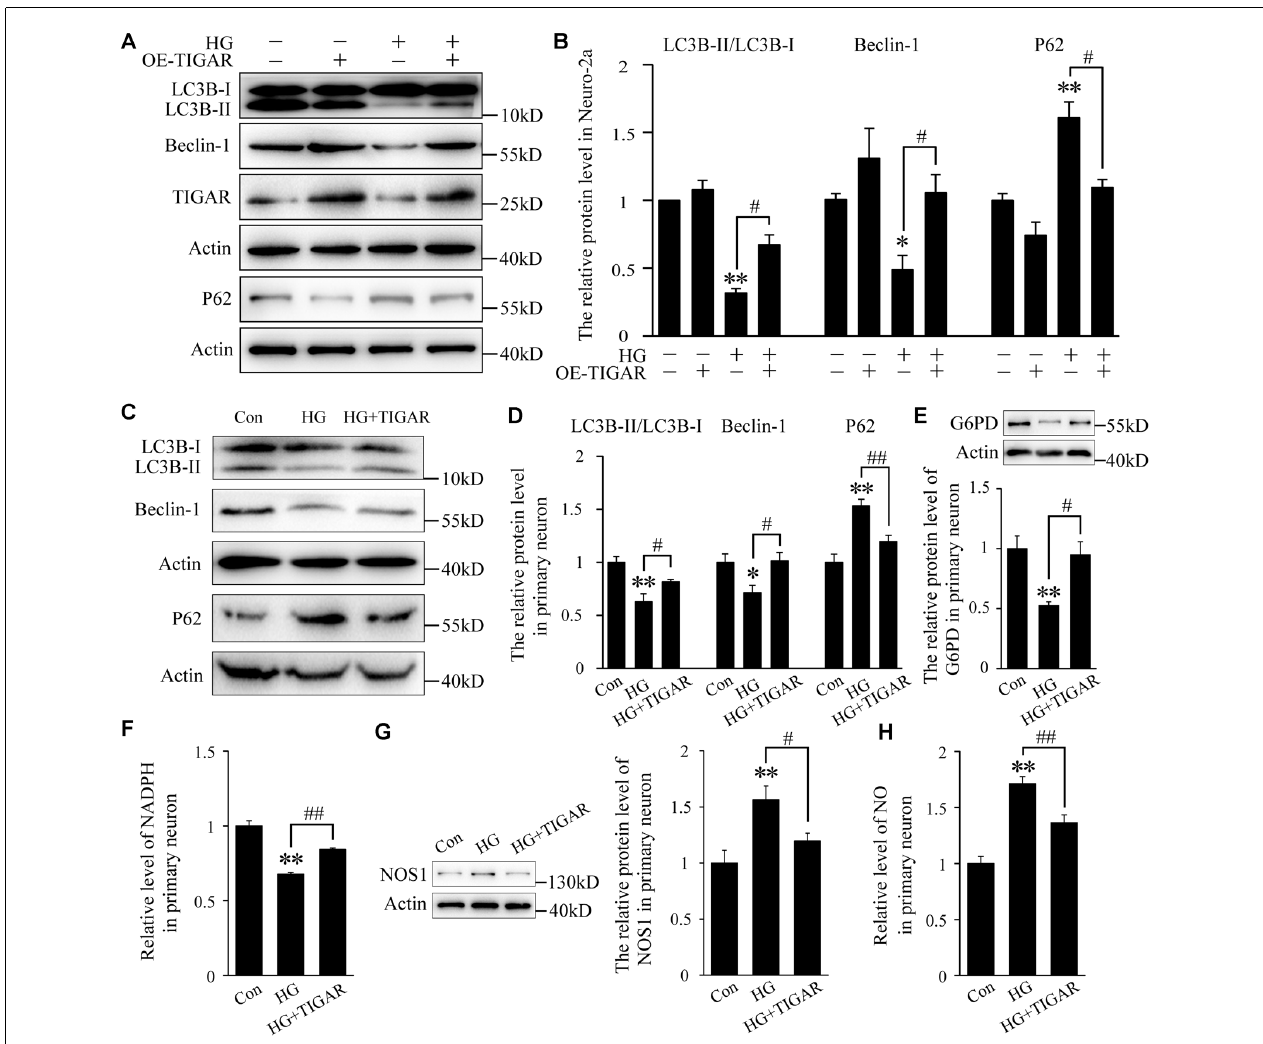
FIGURE 3 | TIGAR ameliorated high glucose-mediated autophagy impairment. (A,B) Western blot analysis of LC3B, Beclin-1, TIGAR and P62 after treatment with Lenti-TIGAR and 50 mM glucose in Neuro-2a cells ( n = 4 per group). (C,D) Western blot analysis of LC3B, Beclin-1 and P62 in primary neuron in each group ( n = 4 per group). (E) Western blot analysis of G6PD in each group ( n = 4 per group). (F) The relative level of NADPH in primary neuron ( n = 6 per group). (G) Western blot analysis of nitric oxide synthase 1 (NOS1) in each group ( n = 4 per group). (H) The relative level of NO in primary neurons ( n = 6 per group). ∗ p < 0.05, ∗∗ p < 0.01 vs. the control group, # p < 0.05, ## p < 0.01 vs. the HG group, one-way or two-way